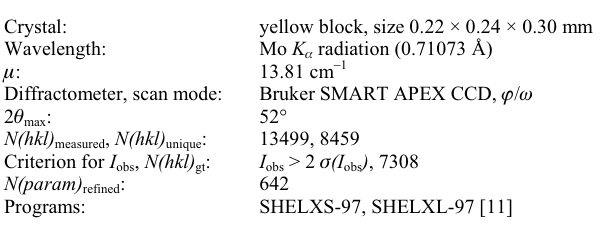
Table 1. Data collection and handling.